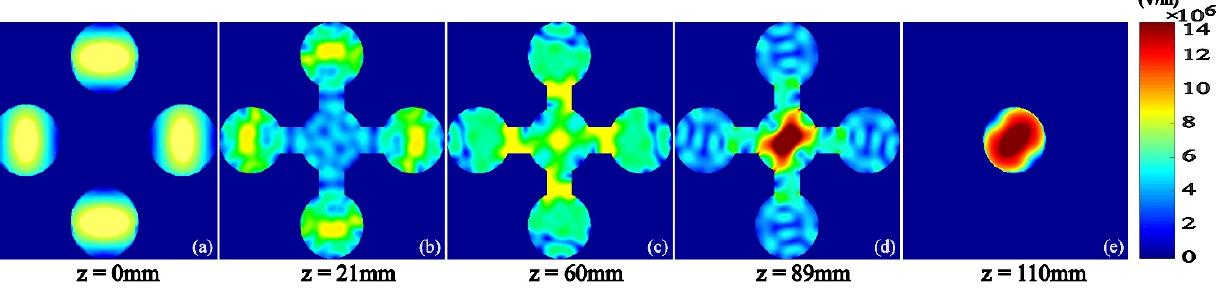
Figure 9. Transverse electric field distribution at different z ( a ) z = 0 mm, ( b ) z = 21 mm, ( c ) z = 60 mm, ( d ) z = 89 mm, and ( e ) z = 110